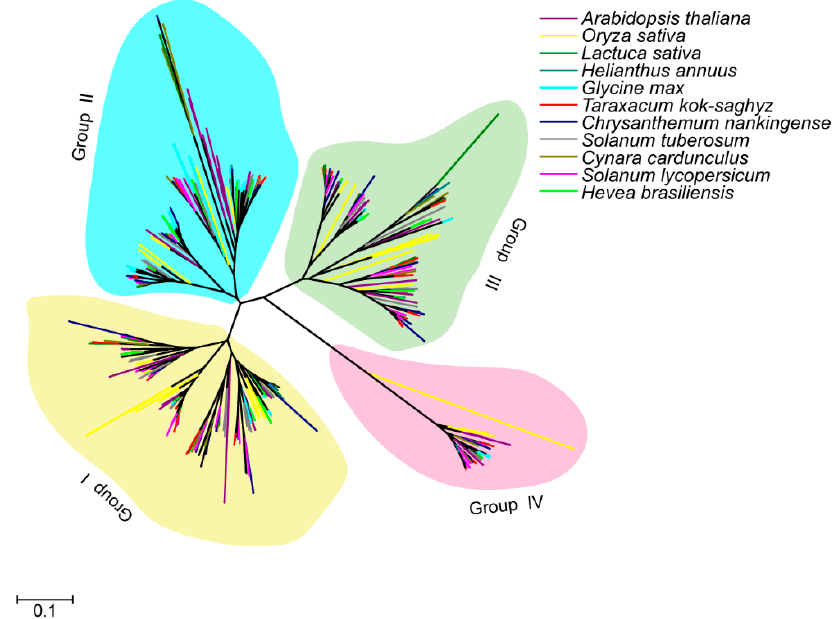
Figure 1. Phylogenetic tree of CPK members in eleven species. The phylogenetic tree was constructed by ClustalX 2.0 and MEGA 7.0 software using the Neighbor-Joining (NJ) method with bootstrap replicates set to 1000. The CPKs from different species are shown in different colors. The constructed phylogenetic tree showed that CPKs are clustered into four different groups: group I (yellow), group II (blue), group III (green) and group IV (pink).